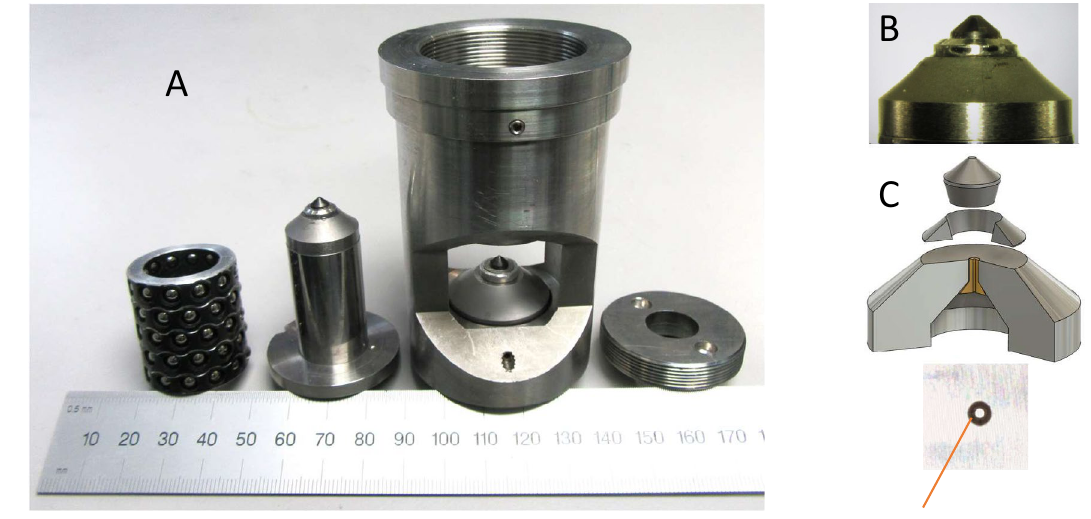
Figure 1. Megabar neutron diamond anvil cell. ( a ) A photo of the individual parts of the cell, roller bearings, top piston including seat and anvil, cell body including opposing seat and anvil, and top closing cap. ( b ) A photo of the seat and anvil including the steel binding ring used for additional support. ( c ) A 3D-schematic created in Autodesk Fusion 360 (V2.0.15050, https:// www. autod esk. com/ produ cts/ fusion- 360) of seat and anvil including the collimator built into the seat consisting of amorphous boron with a small amount of epoxy. A close-up photo of the seat in top-view shows the aperture for incoming beam formed by the collimator. The diameter of the hole in the seat is thereby 1 mm